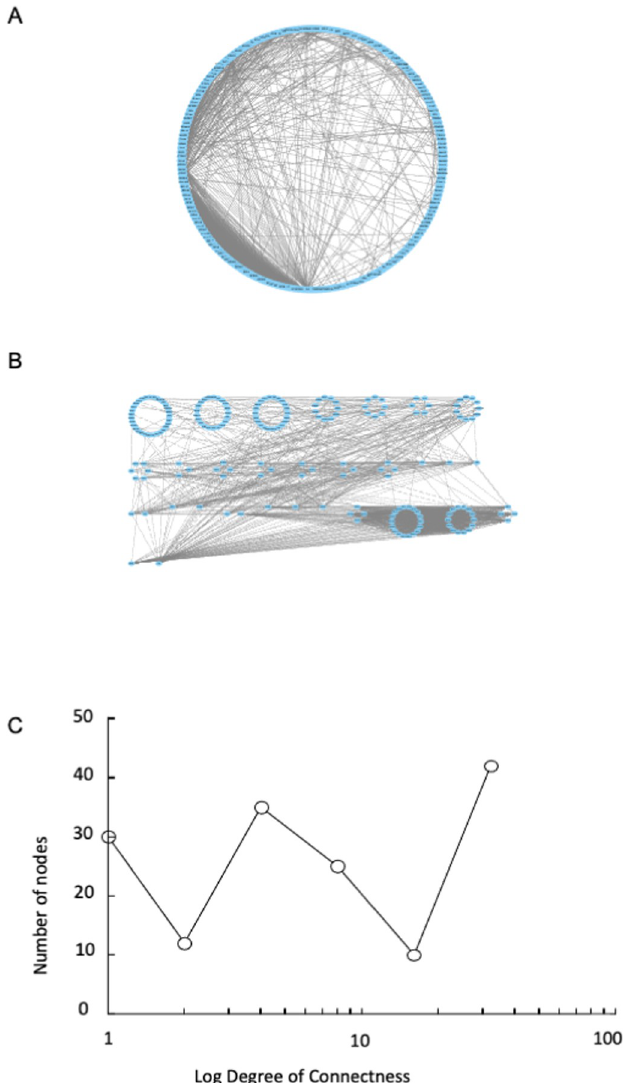
Fig 8. A) overview of gene network. Blue, nodes in the network. Grey lines, known connections between nodes. Some nodes are very highly connected. B) alternate overview of gene network, redrawn to maximally display connections and the most highly connected nodes. Blue, nodes in the network. Grey lines, known connections between nodes. Some nodes are very highly connected. C) graph of node connections. X-axis, number of connections per node; Y-axis, number of